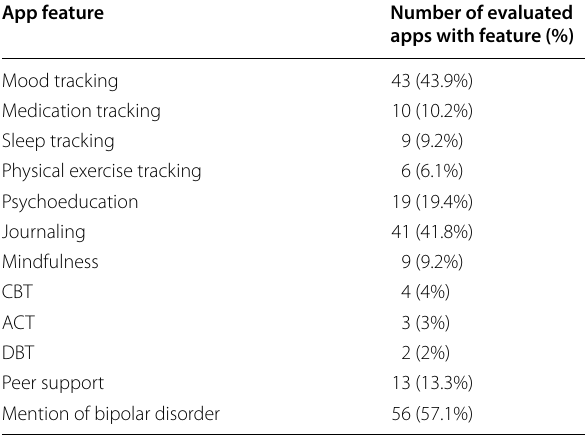
Table 1 Common app features and